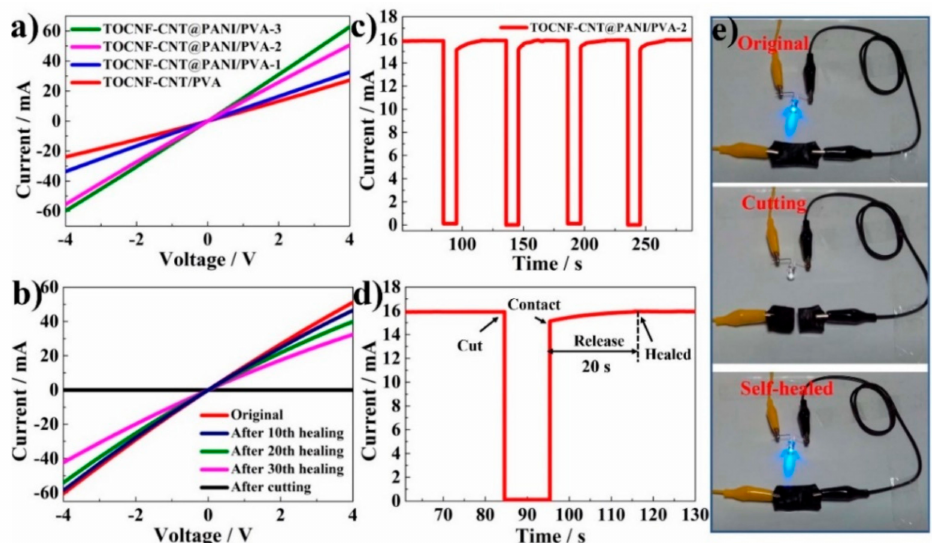
Figure 6. ( a ) Current-voltage ( I–V ) curves of TOCNF-CNT@PANI / PVA with di ff erent doping concentrations of PANI. ( b ) I–V curves of TOCNF-CNT@PANI / PVA-2 hydrogel after